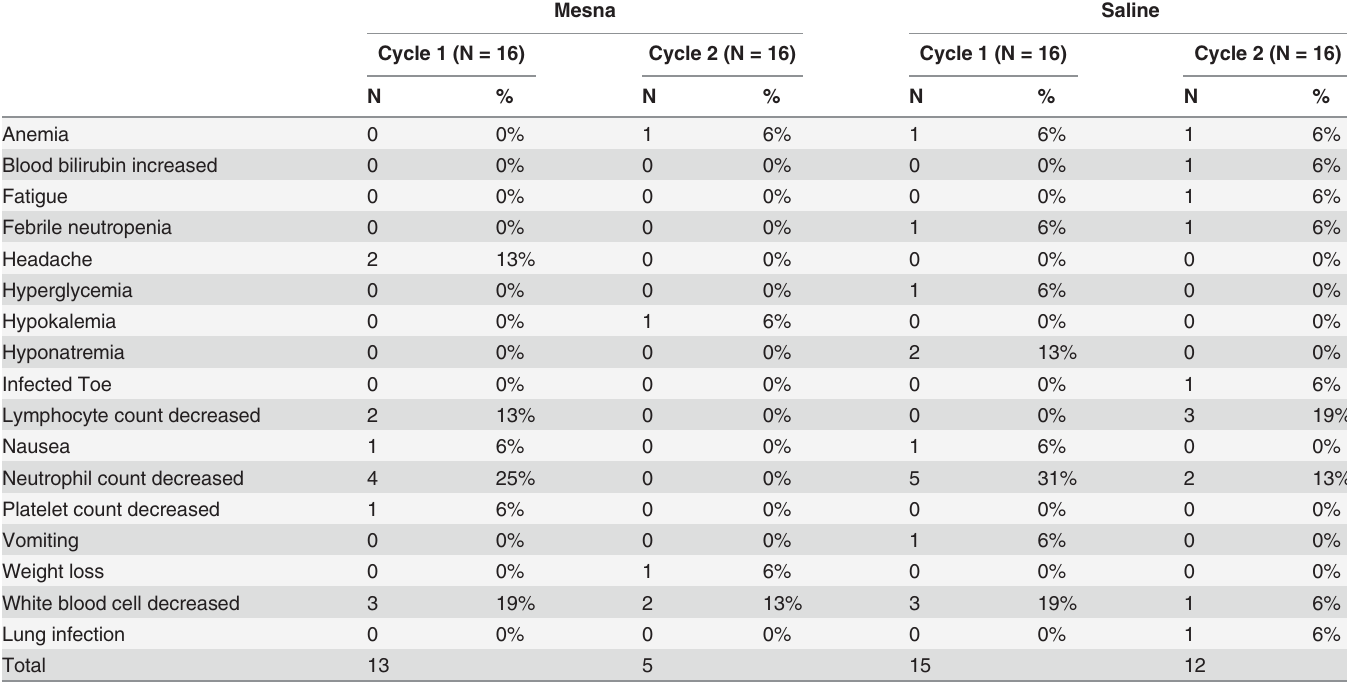
Table 3. All grade 3 or 4 toxicities split by treatment and